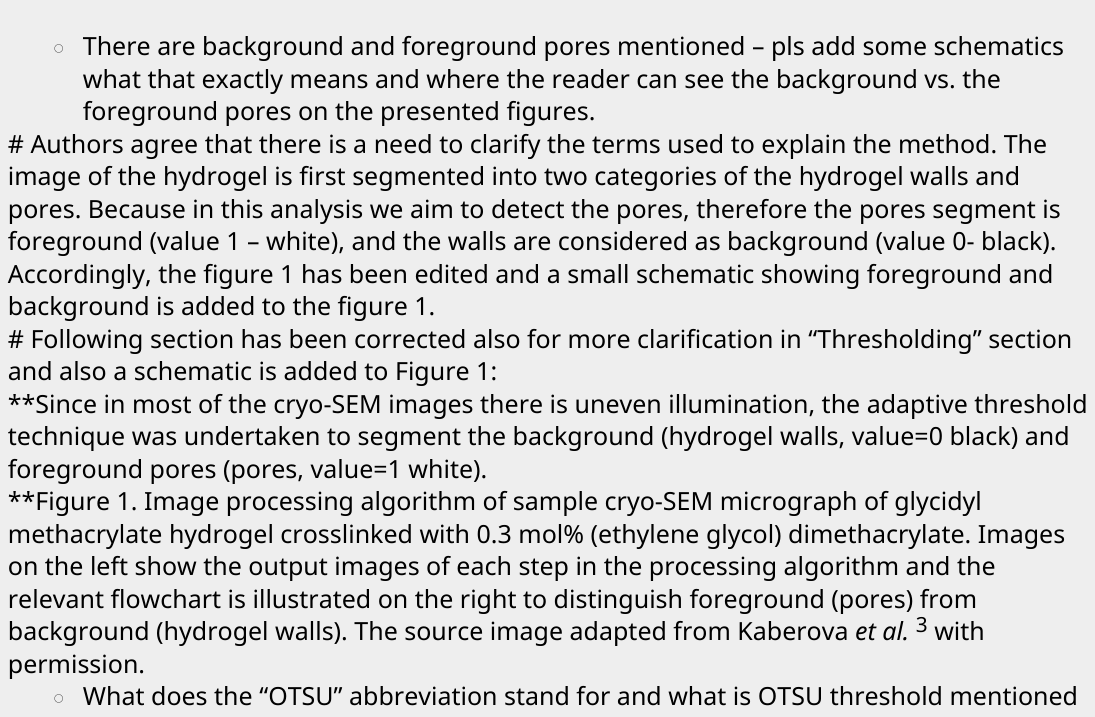
**Figure 1. Image processing algorithm of sample cryo-SEM micrograph of glycidyl methacrylate hydrogel crosslinked with 0.3 mol% (ethylene glycol) dimethacrylate. Images on the left show the output images of each step in the processing algorithm and the relevant flowchart is illustrated on the right to distinguish foreground (pores) from background (hydrogel walls). The source image adapted from Kaberova et al. 3 with permission.